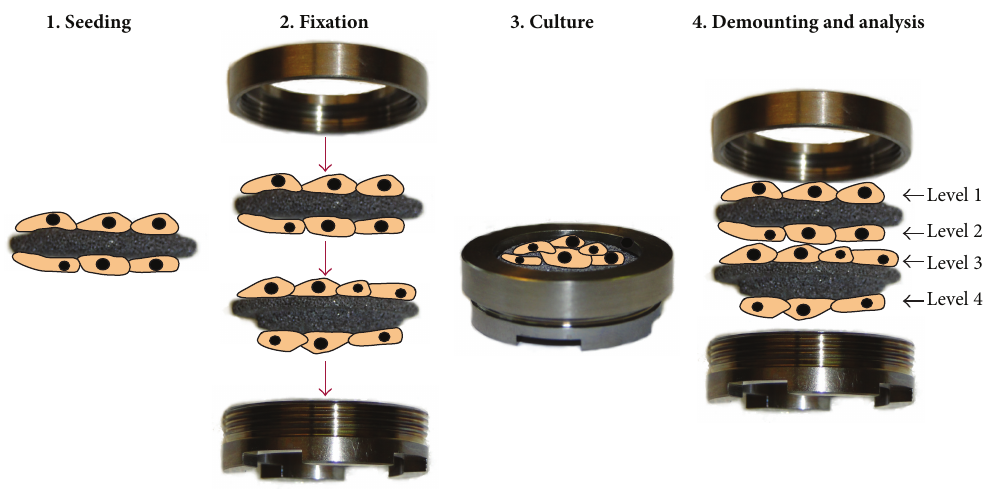
Figure 2: Schematic view of the horizontal fixation of two Ta scaffolds in the clamping ring forming the in vitro 3D module with four separate